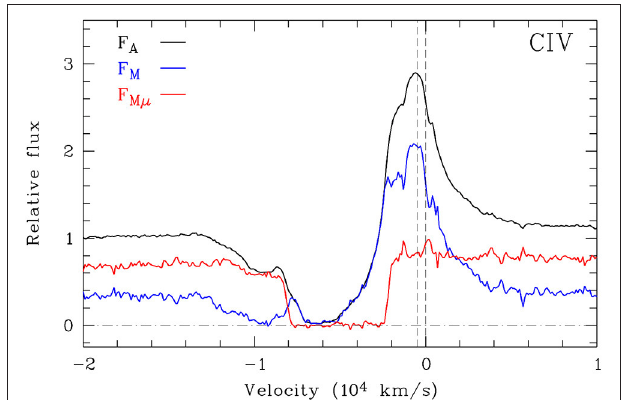
FIGURE 1 | Microlensing in the CIV line of the BAL quasar H1413 + 117. F A is the observed spectrum of image A which is not affected by microlensing. The line profile can be decomposed in a part affected by microlensing, F M µ , and another part not affected by microlensing, F M , with F A = F M + F M µ